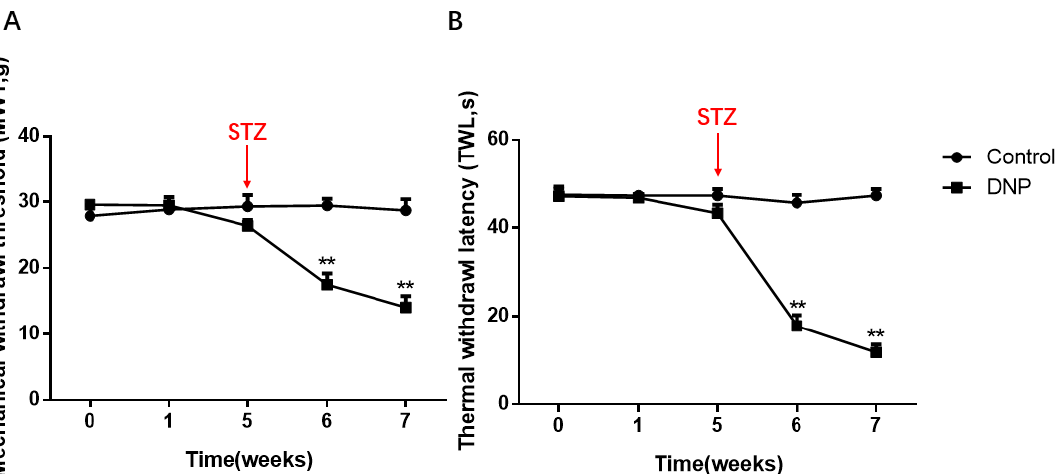
Figure 1. Mechanical withdrawal threshold (MWT) and Thermal withdrawal latency (TWL) in the DNP and Control groups. ( A ) Changes of MWT in normal and model rats. ( B ) TWL changes in the normal and model rats. The MWT and TWLs values of the DNP rats were significantly lower than those of the normal rats. The X-axis means the time of measuring behavior and drug administration, the detailed descriptions of 0, 1, 5, 6 and 7 are given in the Section 4, and we injected the rats intraperitoneally with streptozocin (STZ) at the end of the fifth week; data are shown as mean ± SEM based on at least three independent experiments, n = 6; ** p < 0.01 versus the normal rats.